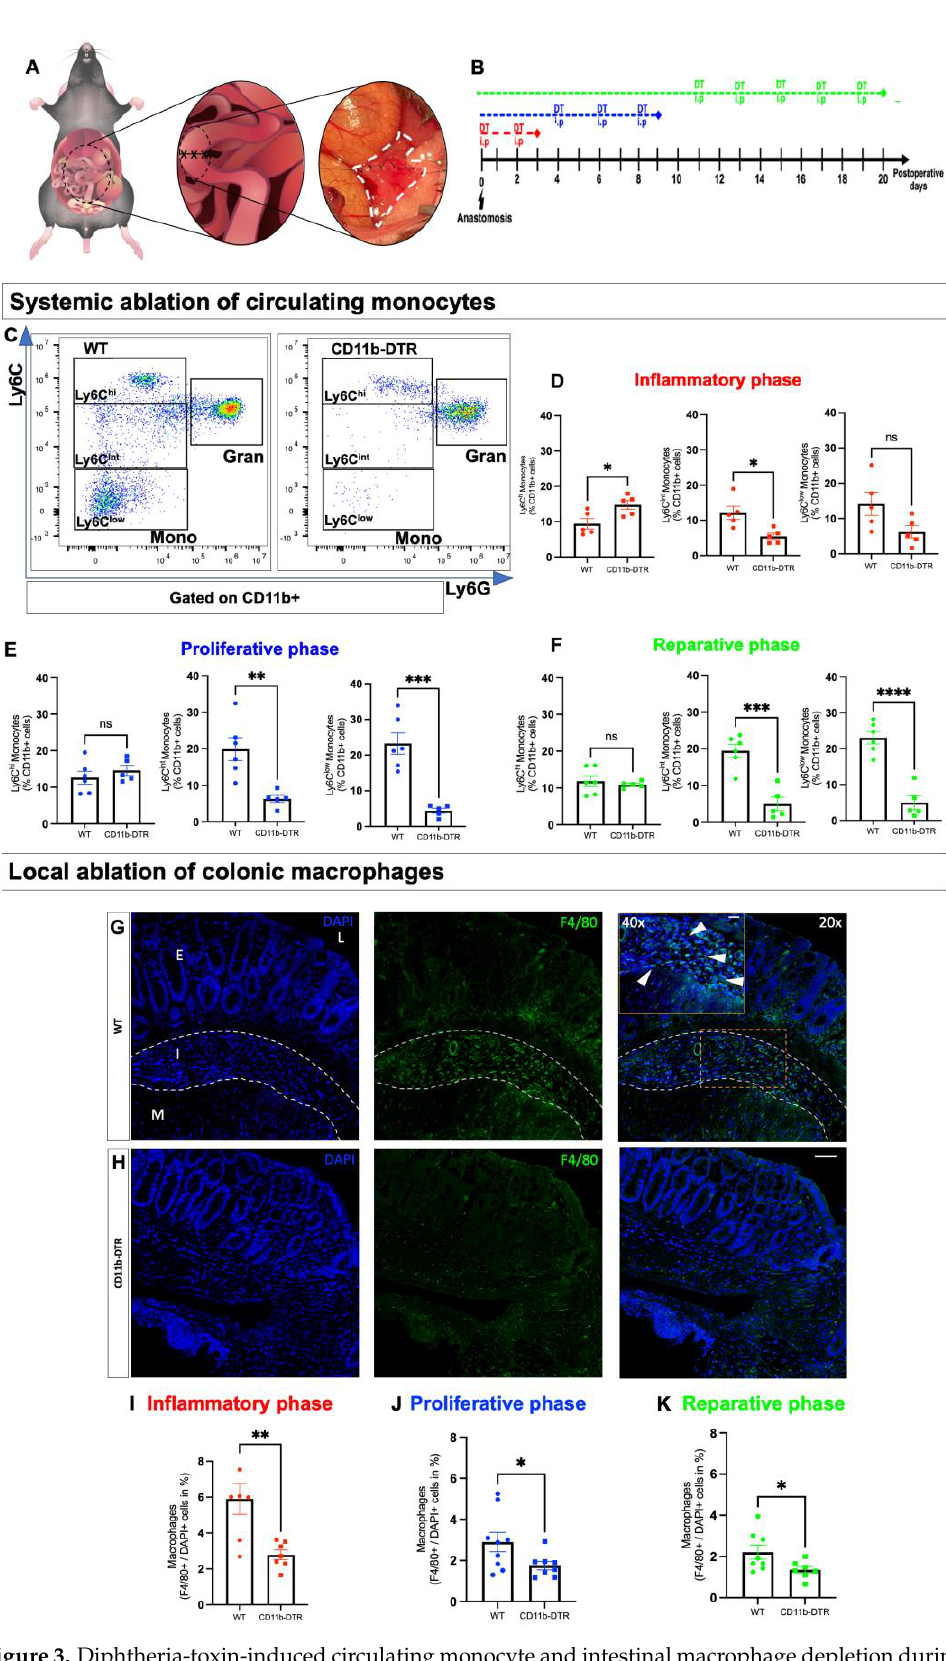
Figure 3. Diphtheria-toxin-induced circulating monocyte and intestinal macrophage depletion during intestinal anastomotic healing. ( A ) Colonic end-to-end anastomosis at the rectosigmoid junction as a model of murine intestinal anastomotic healing (AH) in wild type (WT) and CD11b-diphtheria toxin receptor (CD11b-DTR) mice. ( B ) Post-operative intraperitoneal (i.p) diphtheria toxin (DT)